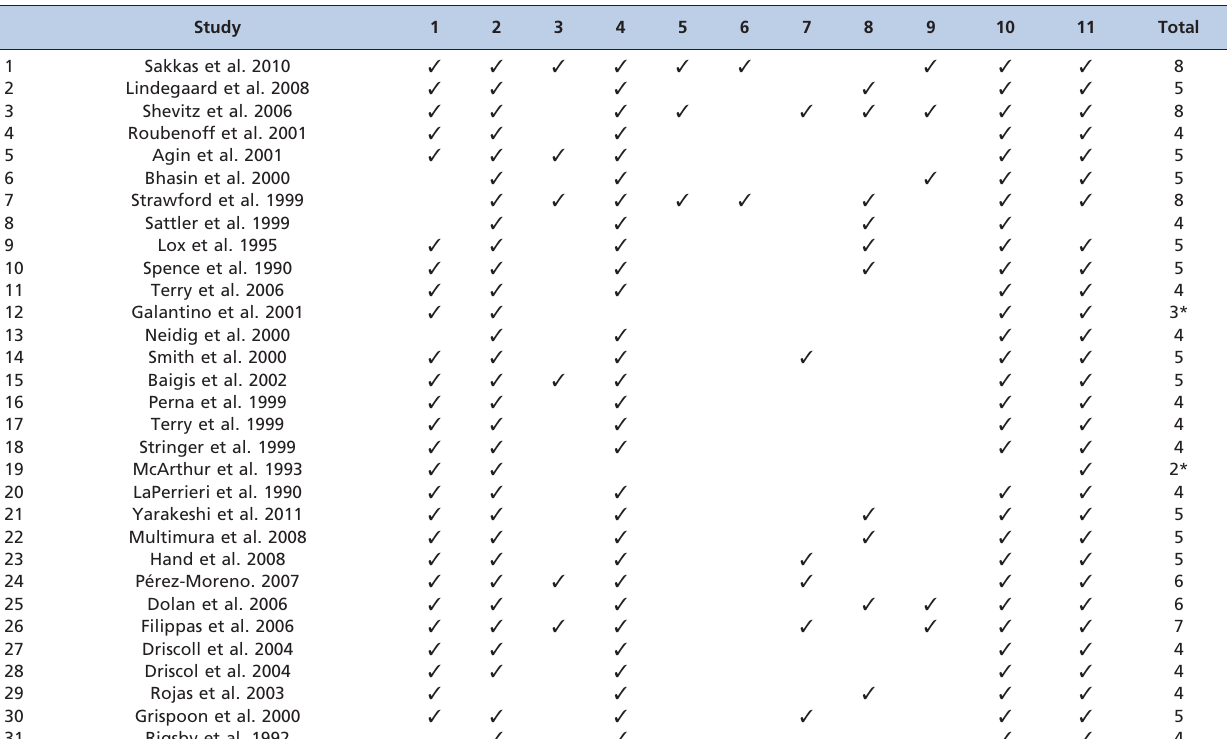
Table 1 - Study quality on the PEDro